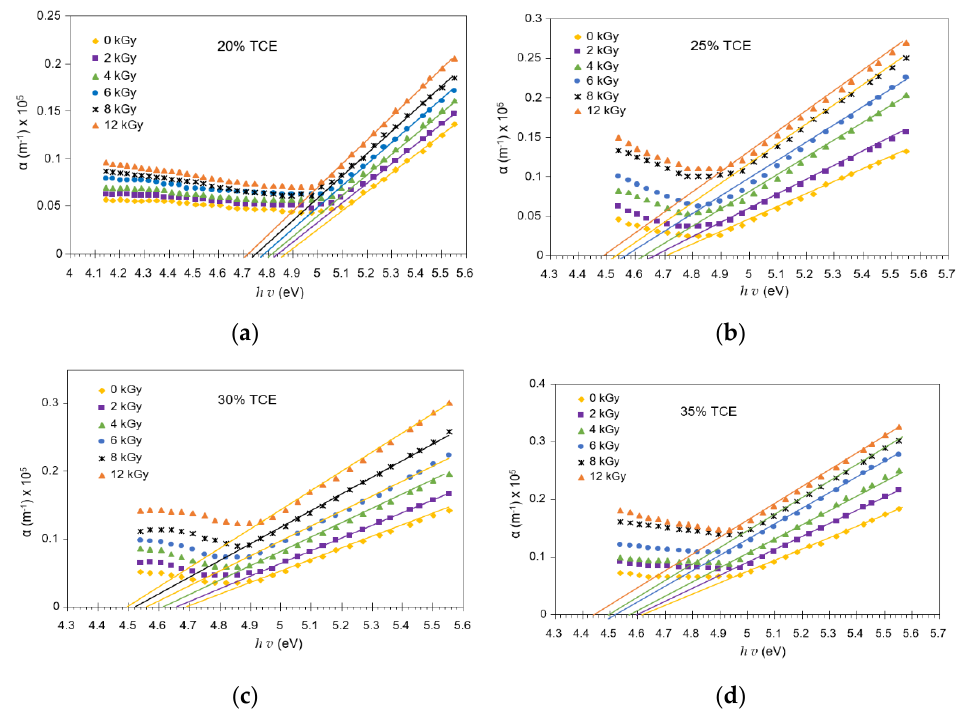
Figure 7. Relationship between α ( v ) vs. hv under different doses for; ( a ) 20%; ( b ) 25%; ( c ) 30%; and ( d ) 35% of TCE content in PVA-TCE-CR polymer film.